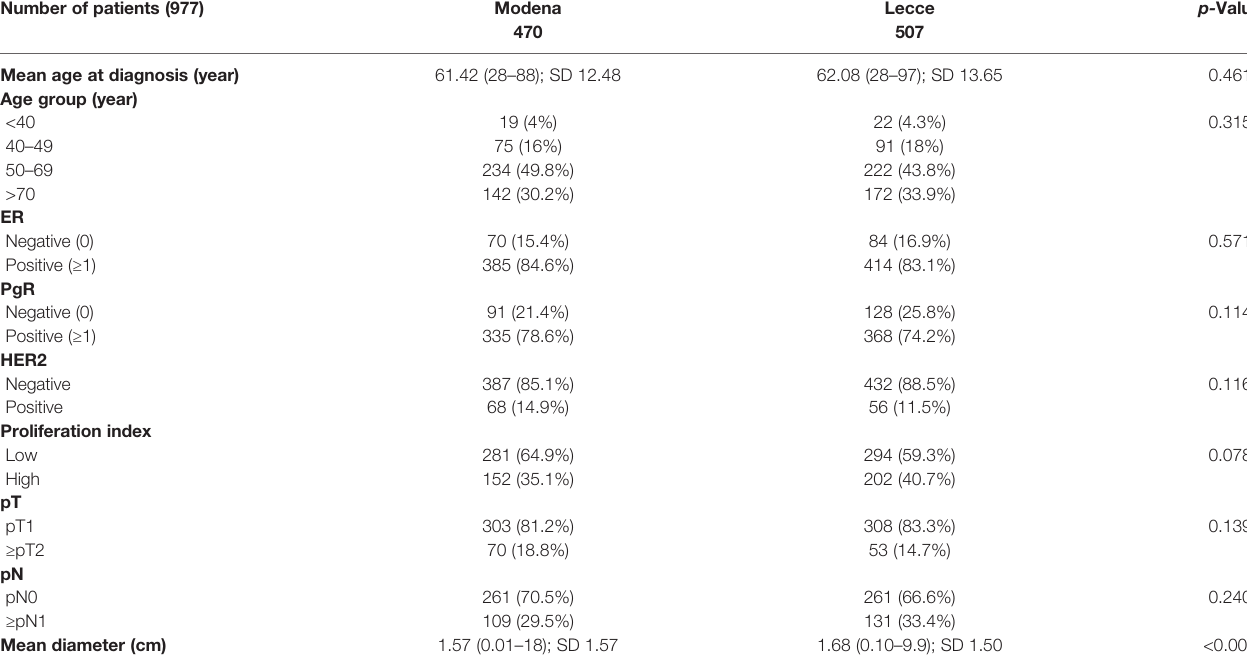
TABLE 1 | Clinical and biological characteristics of BC patients.